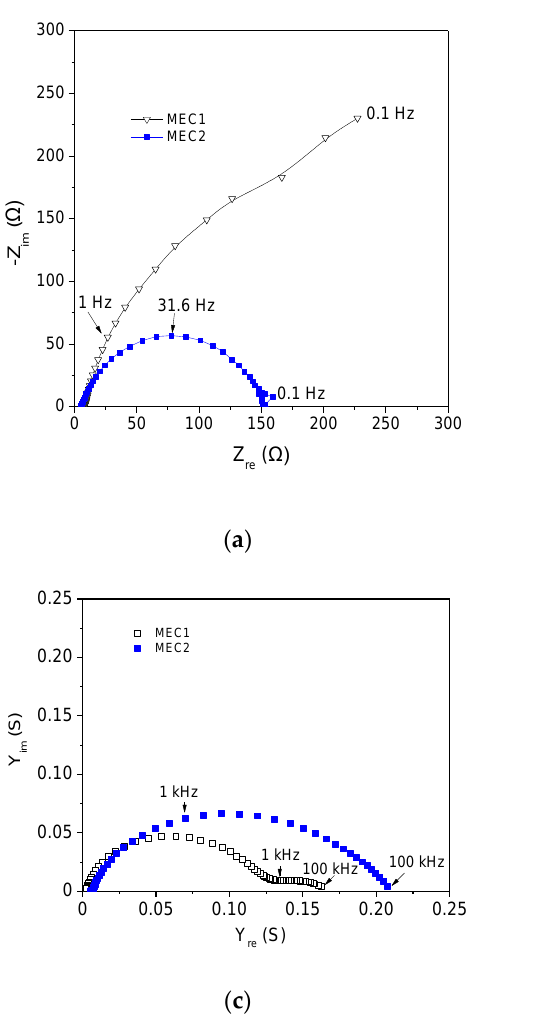
Figure 11. EIS characteristics of the anodes of MEC1 and MEC2 at 0.9 V vs. Ag/AgCl, depicted in the form of ( a ) Nyquist plots, ( b ) phase angle vs. log (frequency) plots and ( c ) admittance plots. ( d ) Current–potential curves, obtained via forward scan of the potential at a rate equal to 10 mV/s. Measurements were conducted in a three electrode set-up (anode as working electrode (WE), cathode as counter electrode (CE) and Ag/AgCl electrode, immersed in the anolyte, as reference electrode (RE). DF effluent was used as substrate in both MECs). Open circuit cell voltages: 0.1 V for MEC1 and − 0.3 V for MEC2.